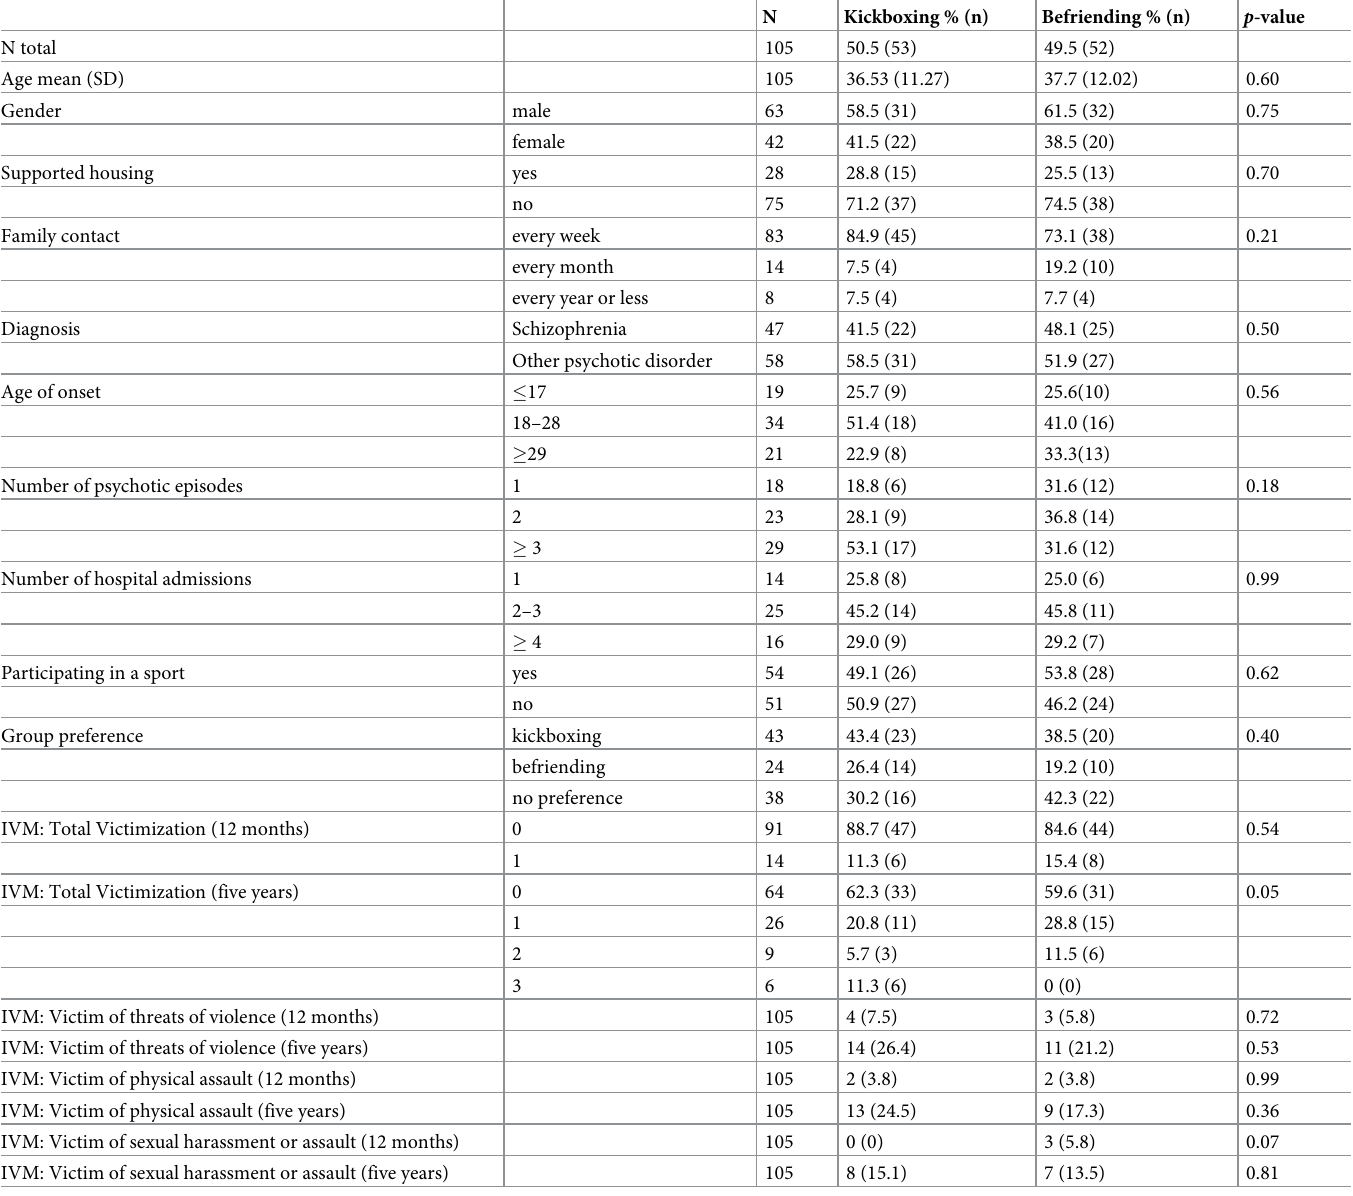
Table 1. Demographic and clinical characteristics at